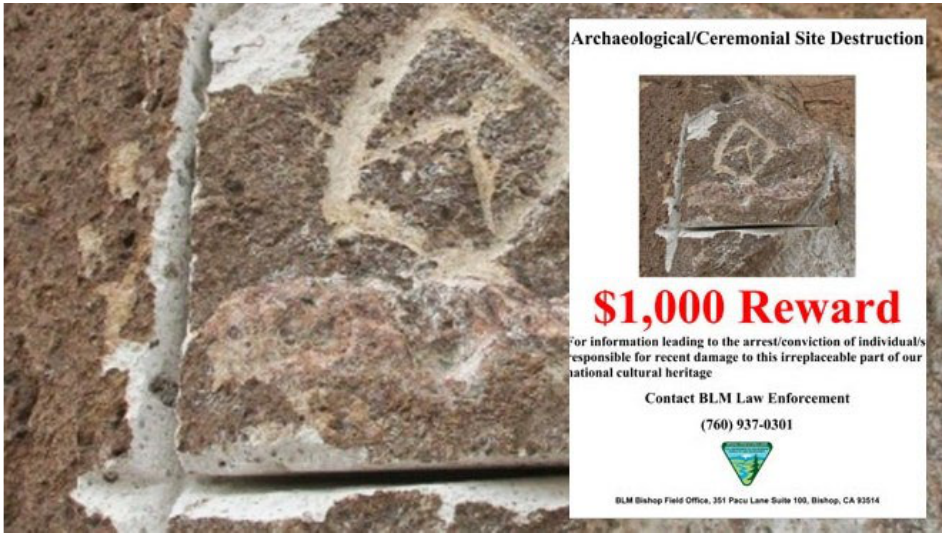
Figure 1. An example of a wanted poster for petroglyph theft [1].